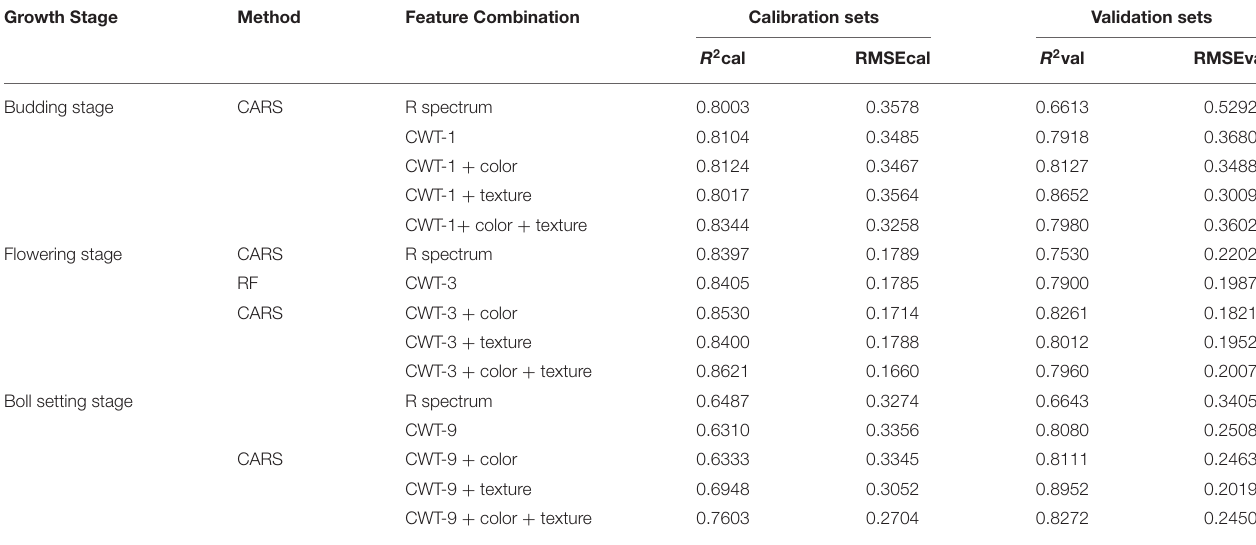
TABLE 5 | PLSR estimation models of the LKC with different combinations of features. Growth